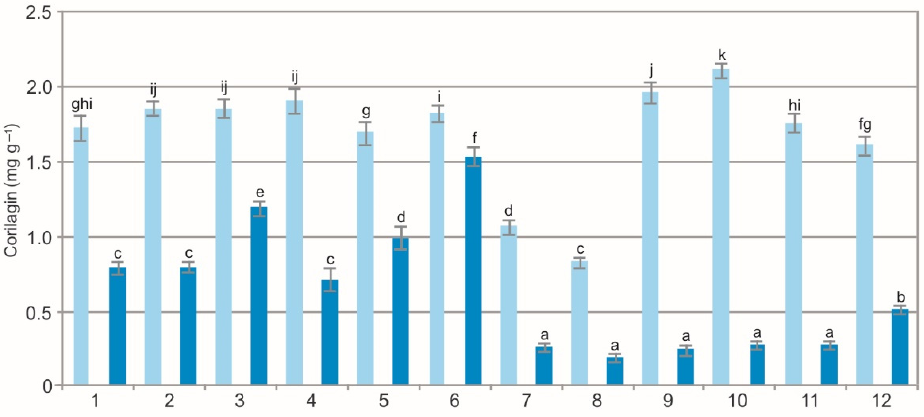
Figure 8. Corilagin concentration in water (light blue) and ethanol (dark blue) leaf extracts from bearberry plants in different populations. The values designated by the different letters are significantly different ( p < 0.05).